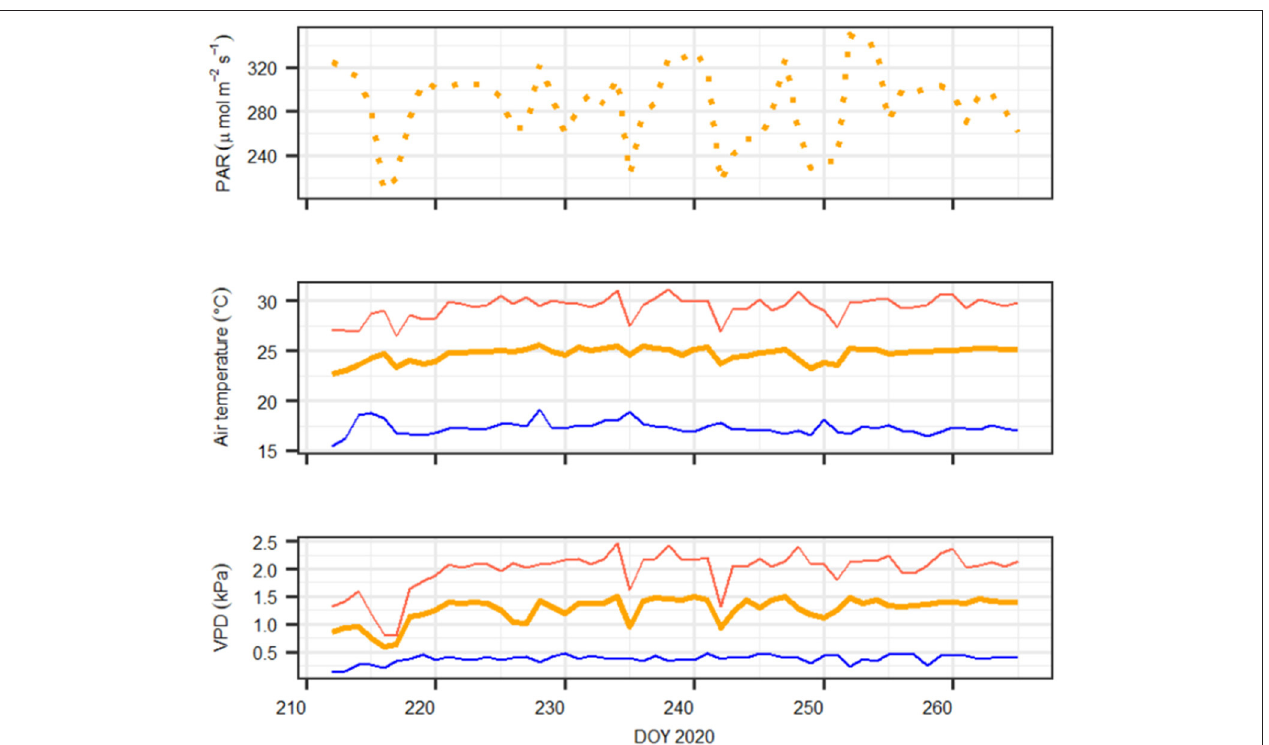
FIGURE 1 | Daily meteorological conditions during the experiment. Upper panel: daylight average photosynthetic active radiation (PAR, in µ mol m − 2 s − 1 ); middle panel: maximum (red), minimum (blue), and average (orange) air temperature (in ◦ C); bottom panel: maximum (red), minimum (blue), and average (orange) atmospheric vapor pressure deficit (VPD, in kPa). Note that on DOY 216–217, vapor pressure deficit (VPD) and temperature conditions were lowest because of a cold weather front that was not compensated by heating the